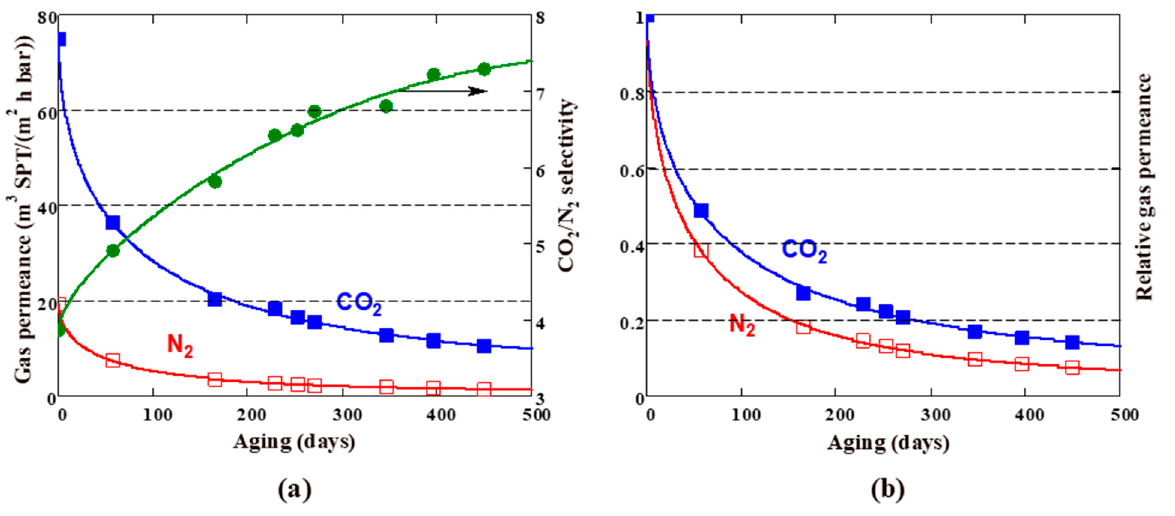
Figure 4. Absolute ( a ) and relative ( b ) CO 2 and N 2 permeances for TFC membrane with PTMSP selective layer vs. aging time. The CO 2 /N 2 selectivity is also shown. Points, experiment; lines, approximation using Equation (9).